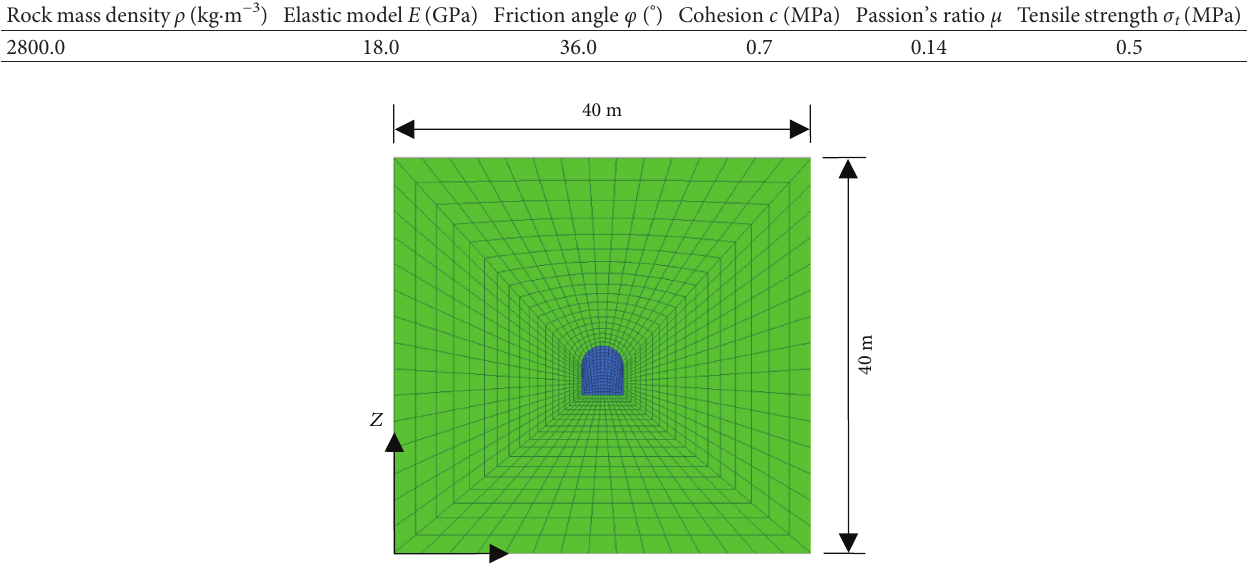
Figure 4: The variation law between σ h.max , σ h.min , σ v , and depth. Table 5: Geomechanical parameters of rock mass.